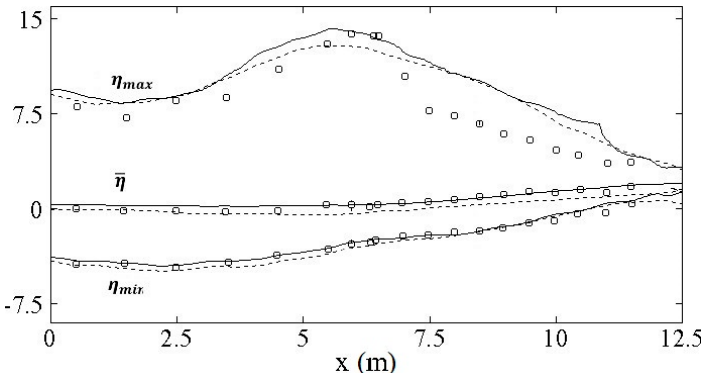
Figure 4. Ting and Kirby [21] spilling breaking wave test case. Mean water level and distribution of phase-averaged crest and trough elevations along the cross-shore. Comparison between experimental data (empty circles), numerical results by Ma et al. [12] (dashed line) and numerical results obtained by the Gallerano et al. [14] without the turbulence model (solid line).